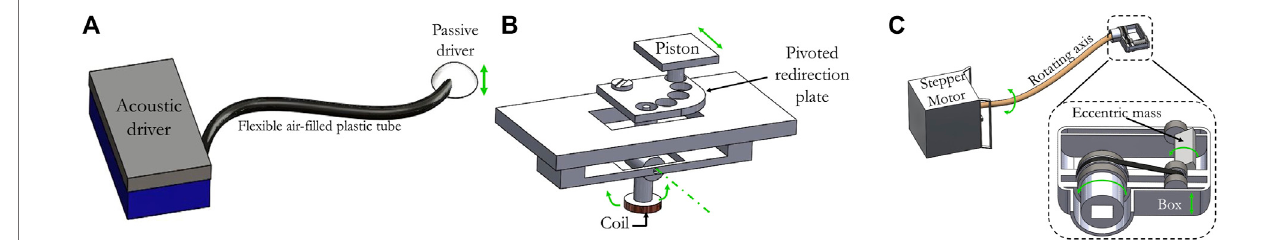
FIGURE 2 | 3D designsofthreeclinicalactuators reported in theliterature. (A) Apressurewaveisgeneratedbytheacousticactivedriver.Then thewaveistransmitted through a plastic tube to a nonmetallic semi fl exible membrane. To date, this is the only mechanical actuator which has been approved by the FDA and is commercially available.Dependingontheapplication,thepistoncanbeadapted[36]. (B) Displacementofthepiston(greenarrow)isachievedusinganalternativecurrent fl owinginthecoil whichisplacedinthestaticmagnetic fi eldB 0 oftheMRImagnet.Thecoiliscoupledrigidlyviaarevolutejoint(revolutionaxisingreen)totheframe.Thepivotedredirection plateallowsthisactuatortoprovidemotionofthepistonindifferentdirectionsunlikecommonelectromechanicalactuators[28]. (C) Thesteppermotorrotatesthesemi fl exible PEEKrotatingaxiswhich is linkedtothe transducer throughalocknutconnection. TwoPEEKrods can befound inthe transducer.Thoserodsare gluedtotwoPEEK timing pulleysandatimingbelt.ThesecondtimingpulleyisconnectedtoaPTFEeccentricmassthatinducesaverticalvibrationofthebox.Thislaterispositionedincontactwiththe sample to generate waves within the tissue. Motion direction of the different mobile parts is indicated by green arrows